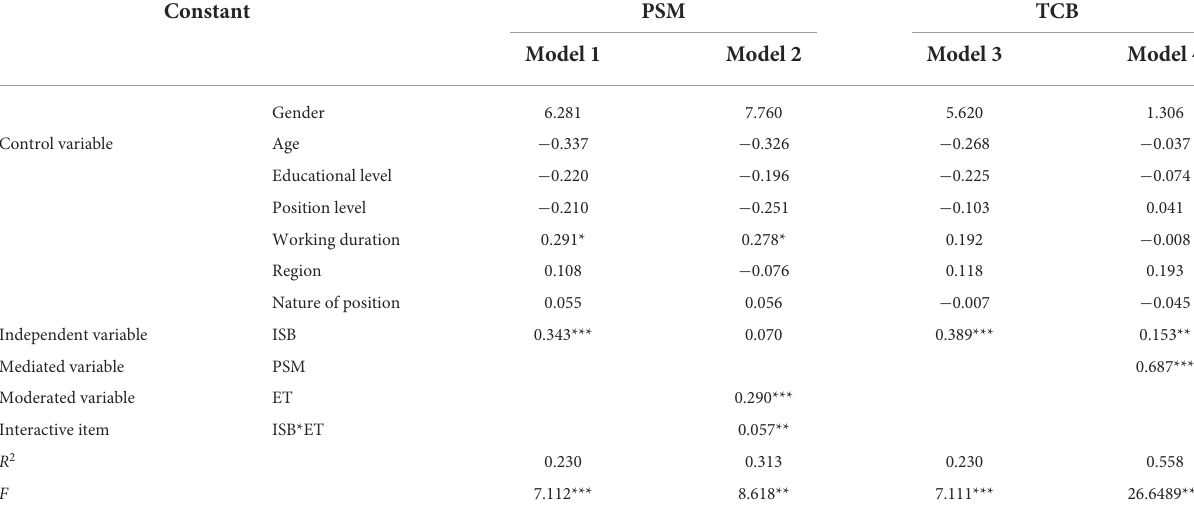
Table 3. In model 3, having controlled gender, age,